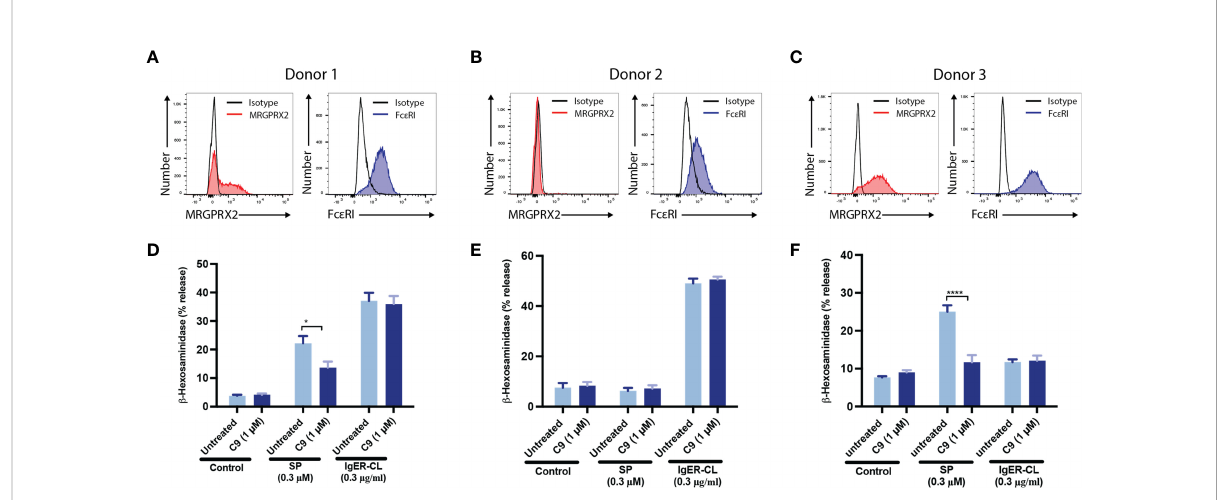
FIGURE 3 C9 inhibits MRGPRX2-mediated degranulation in human skin-derived MCs without affecting the Fc e RI response. (A-C) Flow cytometry histograms demonstrating MRGPRX2 and Fc e RI expression of cultured human skin-derived MCs from 3 healthy donors are shown. (D-F) Cells were preincubated with C9 (1 µM, 5 min) and exposed to SP (0.3 µM) or Fc ϵ RI a -aggregation antibody, IgER-CL (IgE receptor cross-linking) (0.3 m g/ml) and b -hexosaminidase release was determined. Data are expressed as mean ± SEM. Statistical signi fi cance was determined by two-way ANOVA test at a value * P < 0.05, and **** P <